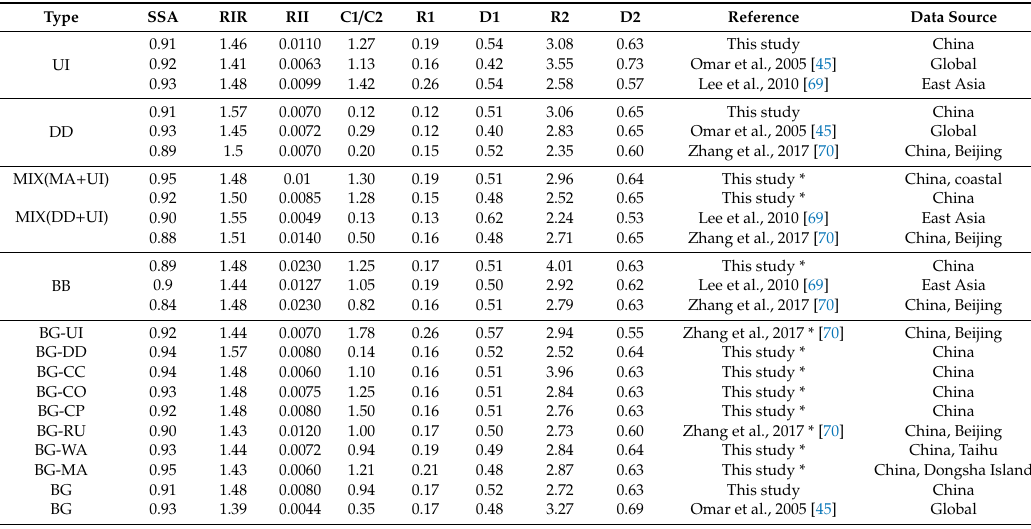
Table 2. Summary of aerosol properties for di ff erent types in